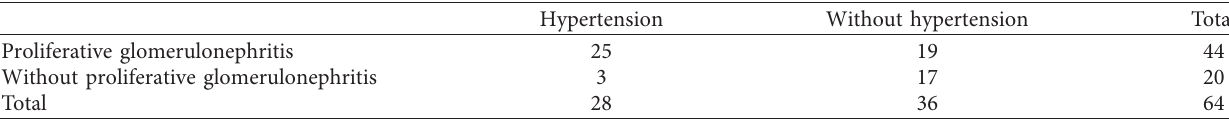
Table 2: Cross table of cases and